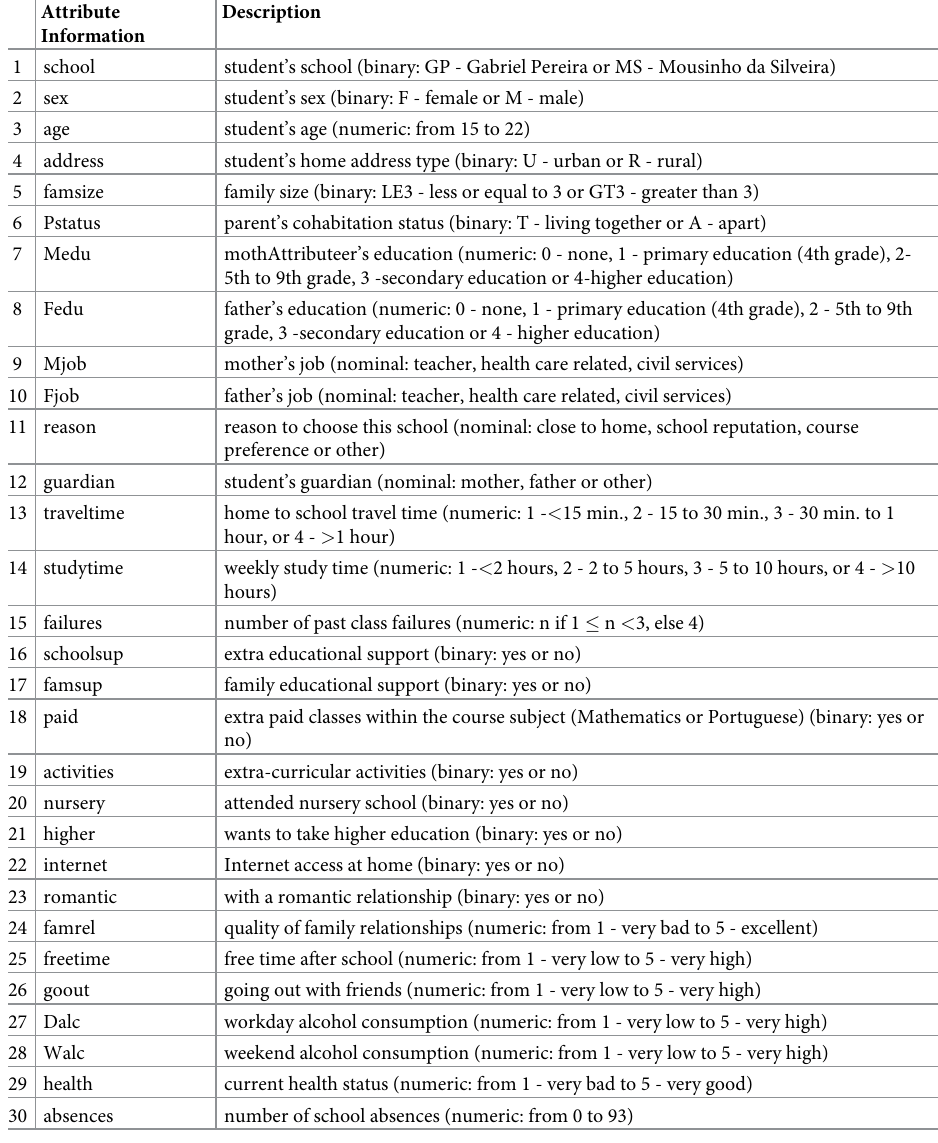
Table 1. Attribute information for student performance data